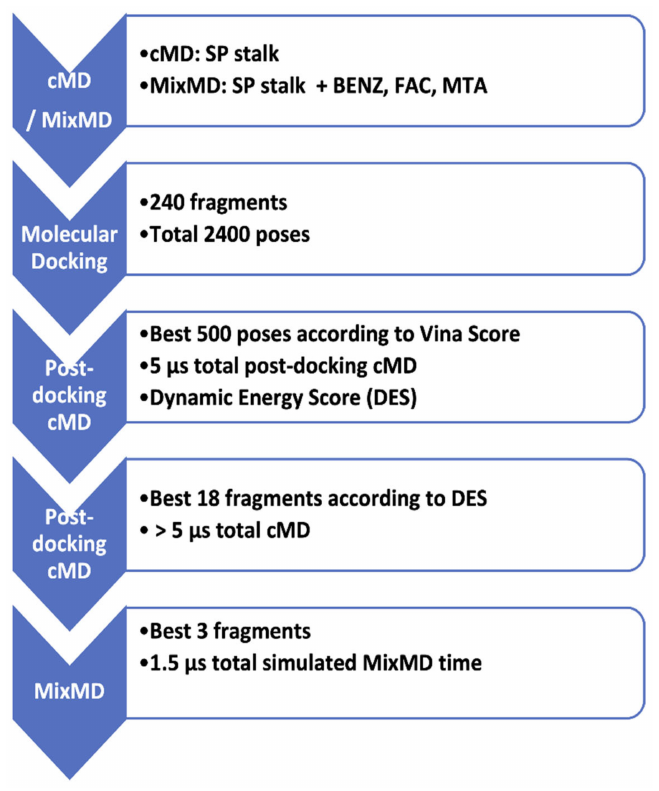
Figure 2. Computational workflow of the study. Preliminary classic molecular dynamics (cMD) and mixed MD (mixMD) were performed on the spike protein stalk (SP); an MD-extracted conformation of the SP stalk was used to dock 240 molecular fragments. The best 560 poses according to Vina score were subjected to 10 ns of cMD ed evaluated according to the dynamic energy score (DES, Equation (1)). The best five fragments according to DES were further simulated through cMD and mixMD. BENZ: benzene; FAC: formic acid; MTA: methylamine. These fragments contain the basic functional groups, namely aromatic (benzene, BENZ), hydrogen bond donors (formic acid, FAC; methylamine, MTA), hydrogen bond acceptors (FAC), and aliphatic hydrophobic